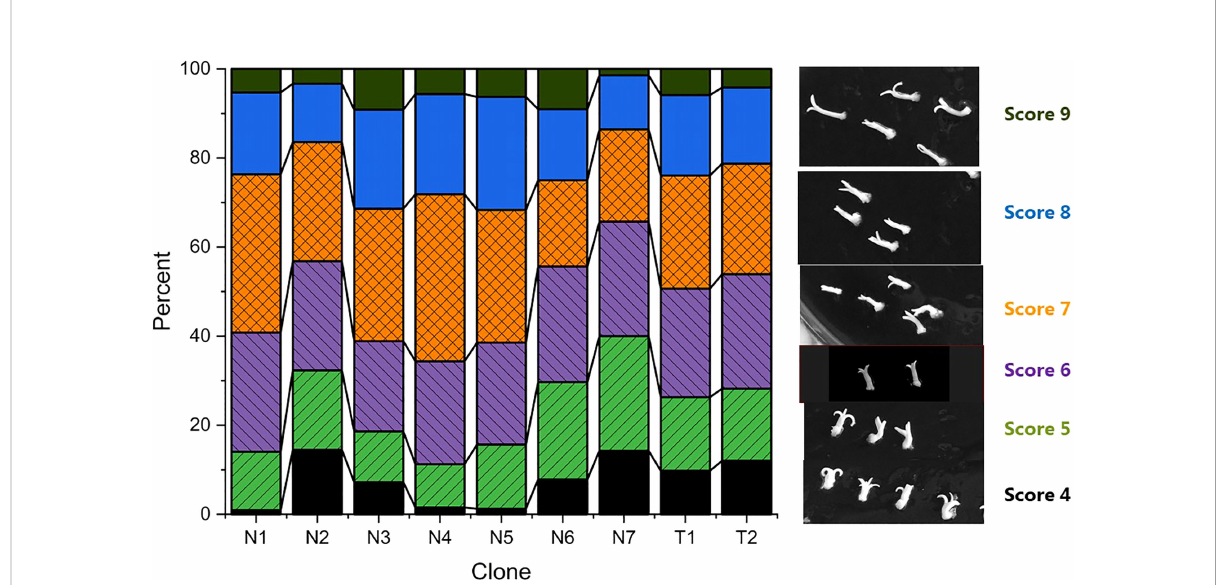
three seasons (Tables S1, S2). Identity-records of each of the germinated embryos were kept respectively through all three steps of the experiment. An overview and timeline of the full experimental set up is shown in Figure 2.